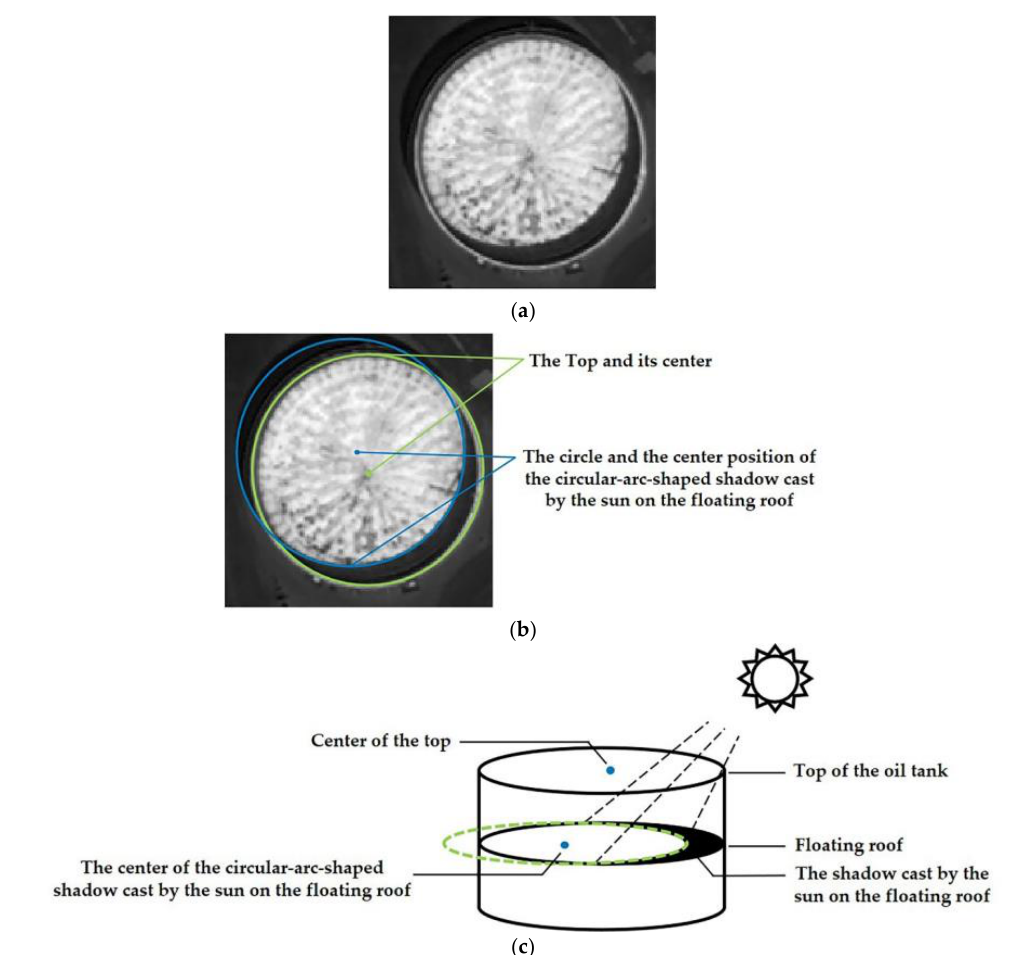
Figure 1. Structural diagram of floating roof oil tank. ( a ) Original image; ( b ) top of oil tank and circle of circular arc on the floating roof; ( c ) three-dimensional structure of floating roof oil tank.